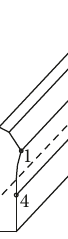
Figure 9: Retaining wall measuring point